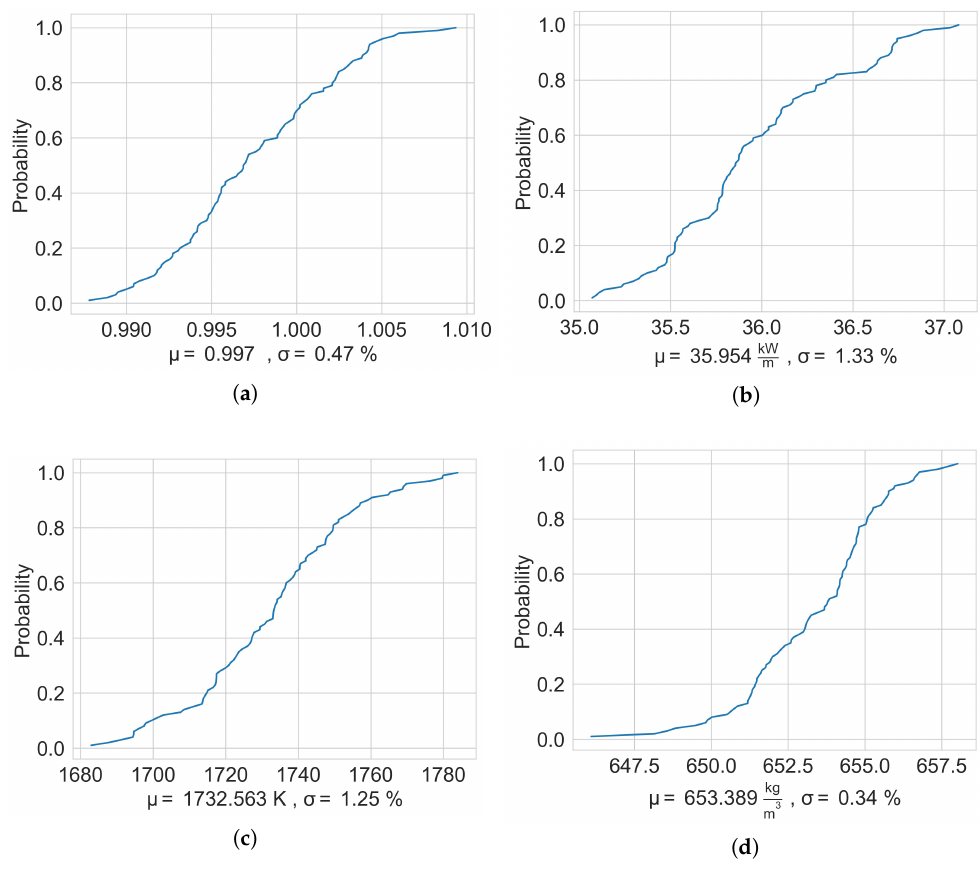
Figure 27. ECDF of ( a ) k eff , ( b ) P max